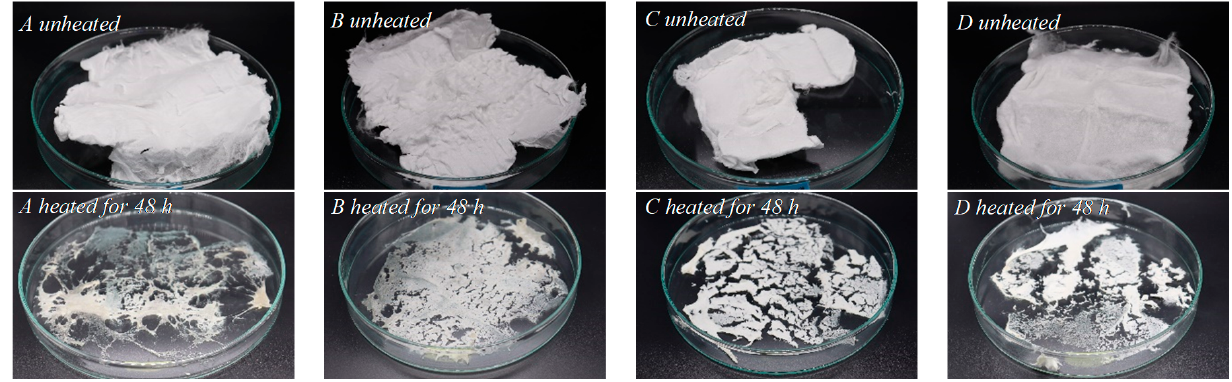
Figure 5. Photos of the fibers from blend ( A ) (80:10:5), ( B ) (80:10:10), ( C ) (80:10:15) and ( D ) (80:10:20) unheated and after 48 h of heating at 65 °C and 75% RH.